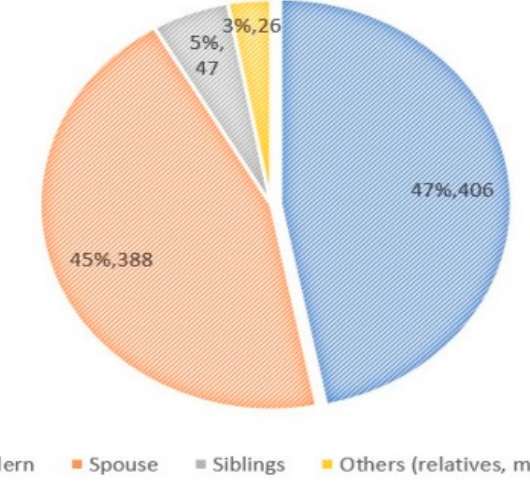
Figure 1. Relationship of primary caregivers with senior citizens, Maehia subdistrict, Chiang Mai, Thailand, 2019.